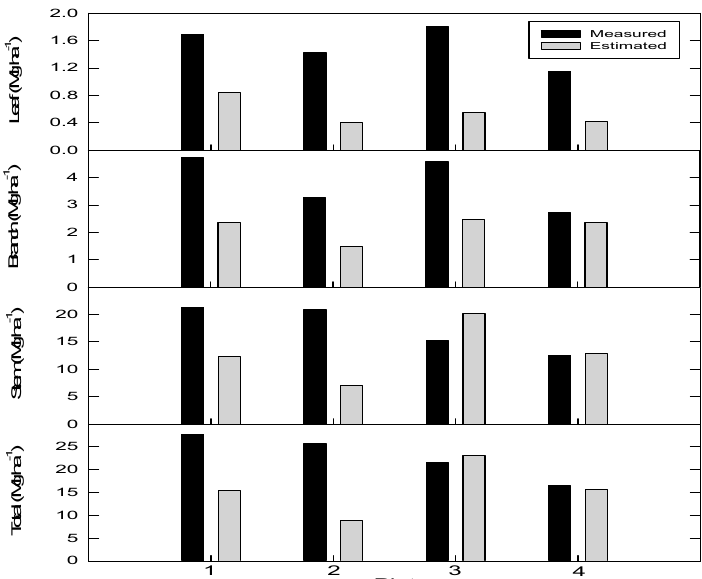
Figure 3. Measured (black bars) and estimated allometric aboveground biomass (gray bars) of each plot in this study.